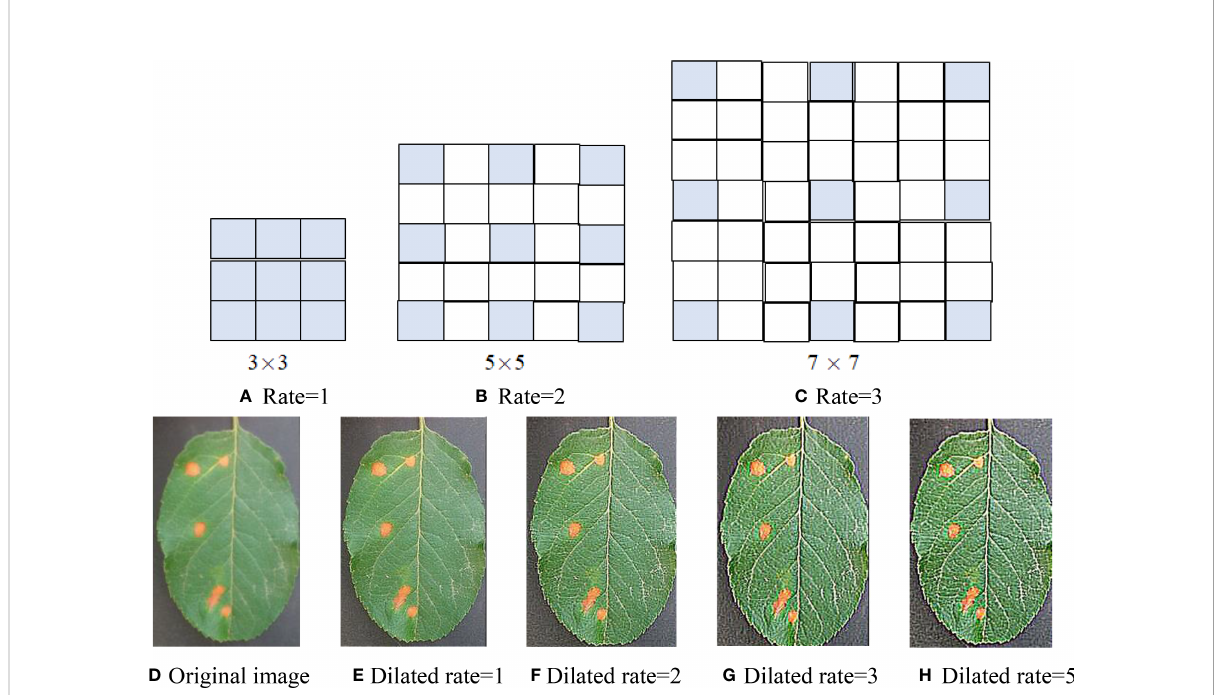
FIGURE 1 Dilated convolution with three dilation rates. (A) Rate = 1. (B) Rate = 2. (C) Rate = 3. (D) Original image. (E) Dilated rate = 1. (F) Dilated rate = 2. (G) Dilated rate = 3. (H) Dilated rate =